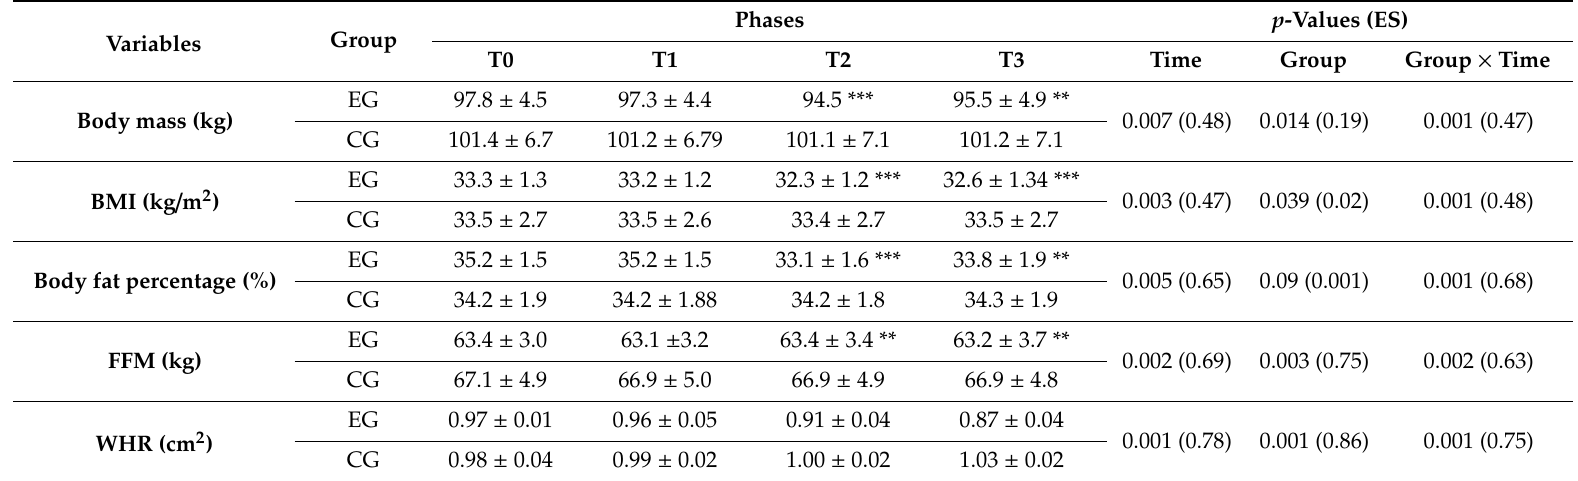
Table 2. Anthropometric and body composition characteristics (means ± SD) of the experimental group (EG) and control group (CG) measured 24 h before the start of Ramadan (T0), on the 15th day of Ramadan (T1), the day after the end of Ramadan (T2) and 21 days after the end of Ramadan